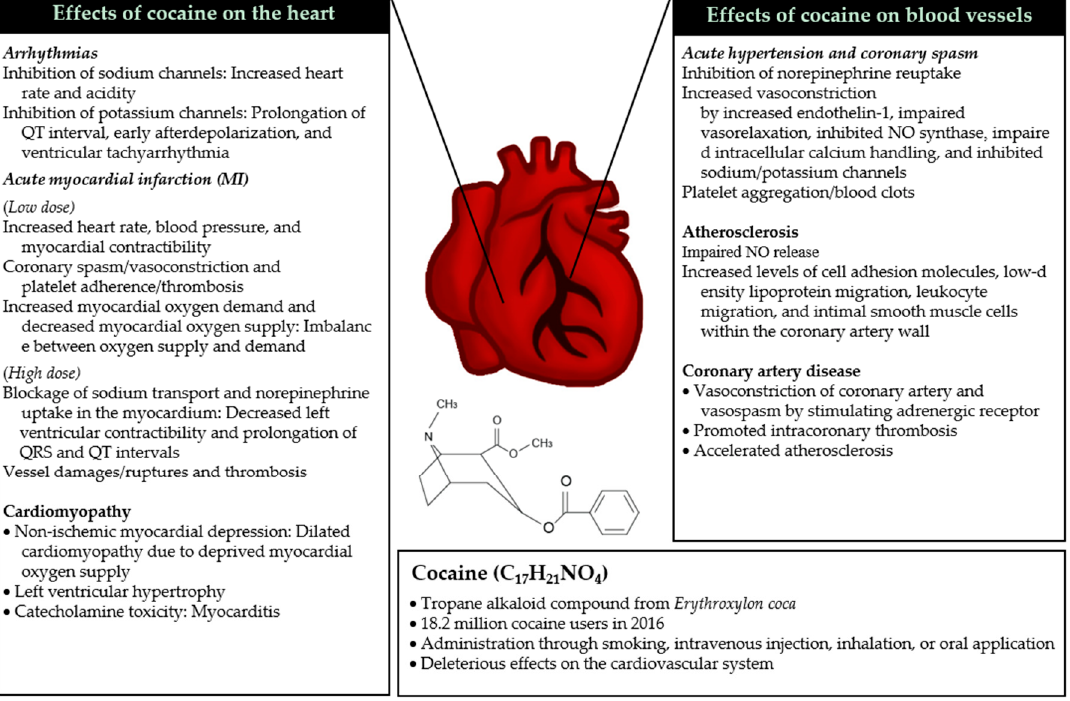
Figure 1. Effects of cocaine on cardiovascular health. Use of cocaine (bottom) results in both acute (italic) and chronic (normal) changes in the heart (left) and blood vessels (right). (Note: Cocaine often induces cardiac condition(s) (e.g., acute myocardial infarction (MI) and coronary artery disease) by affecting the heart and vessels simultaneously).